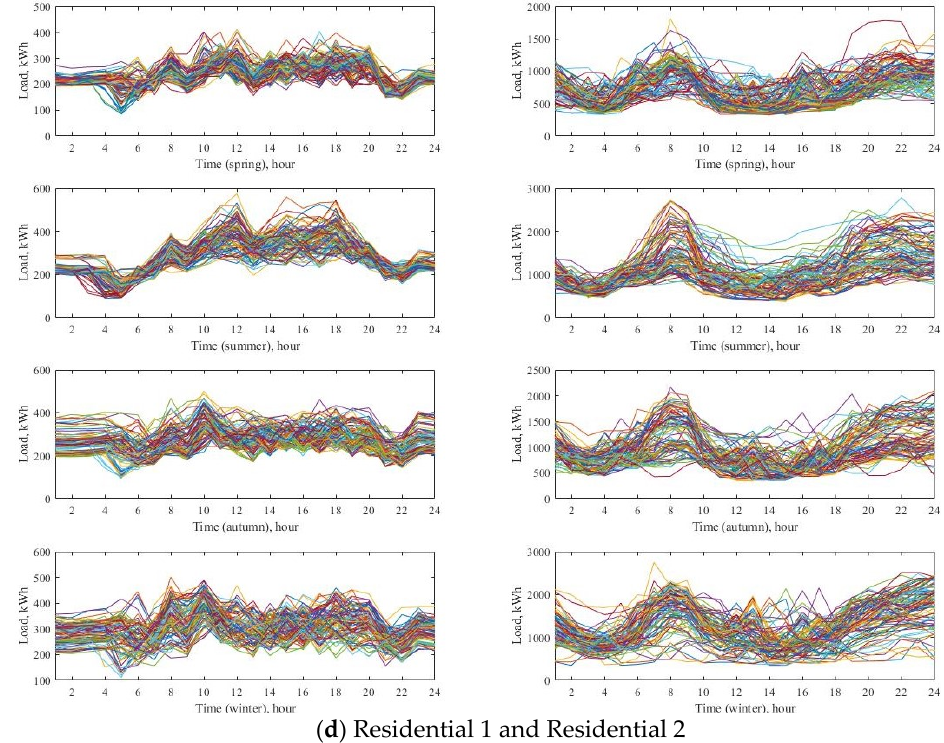
Figure A2. Typical daily changes in the four seasons of museum ( a ), hospital ( b ), shopping mall ( c ) and residential buildings ( d ) (electricity load).